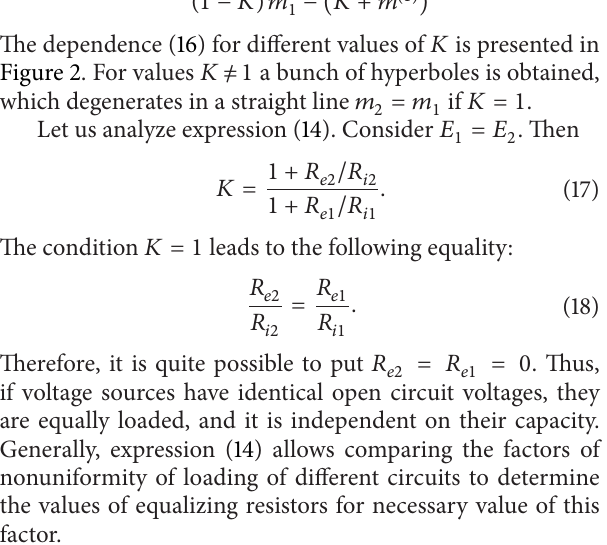
Figure 3: Display of projective transformation of points 𝑚 1 → 𝑚 2 , → 𝐽 𝐽 1 2